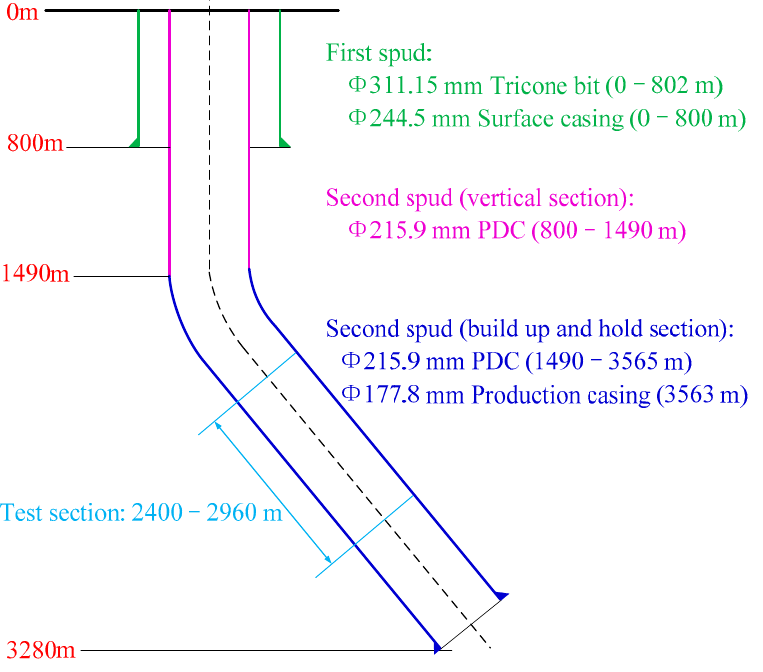
Figure 10. The casing program of a directional well Figure 10 . The casing program of a directional well B.